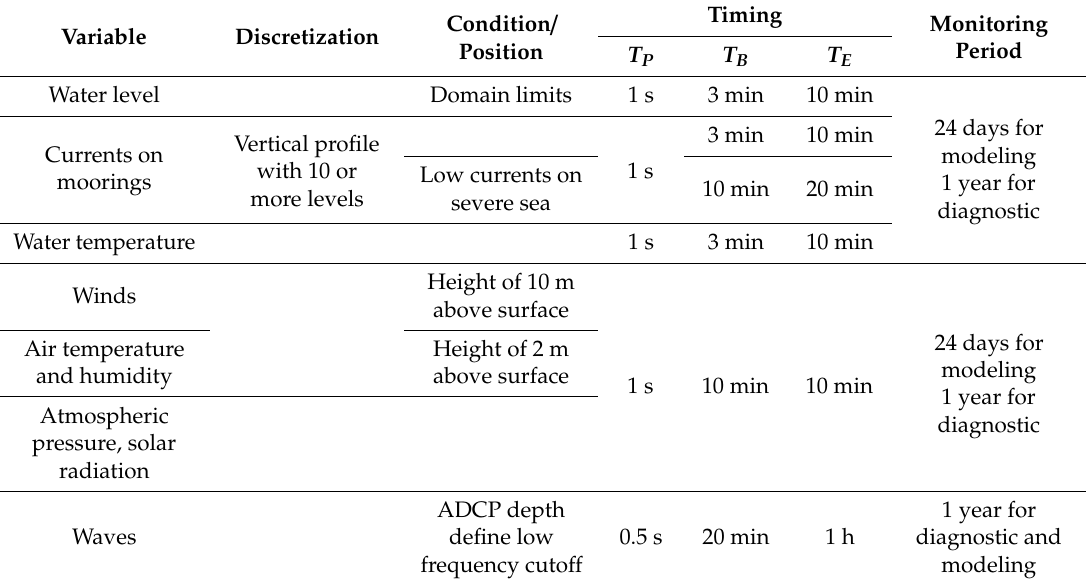
Table 2. Values of ensemble timing under di ff erent sea